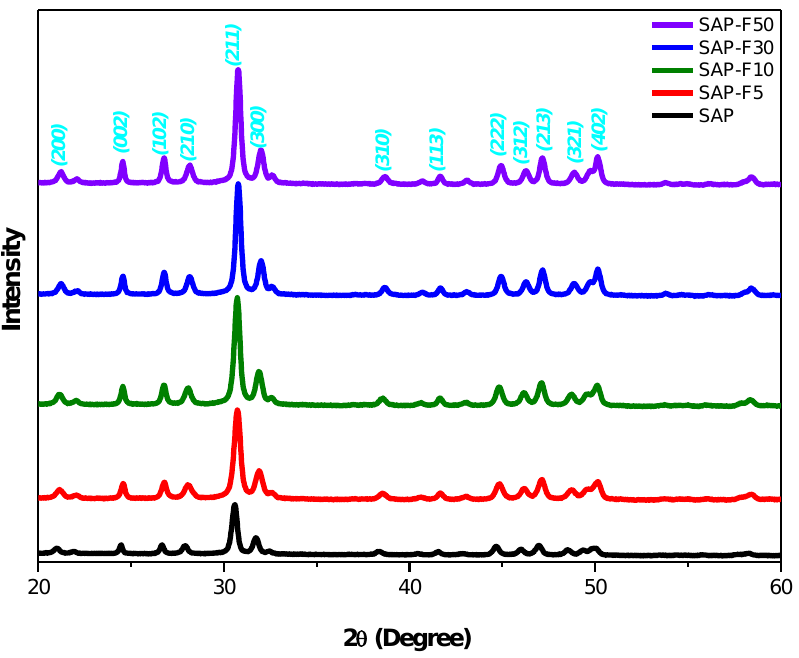
Figure 2. XRD analysis results of synthesized nanoparticles.